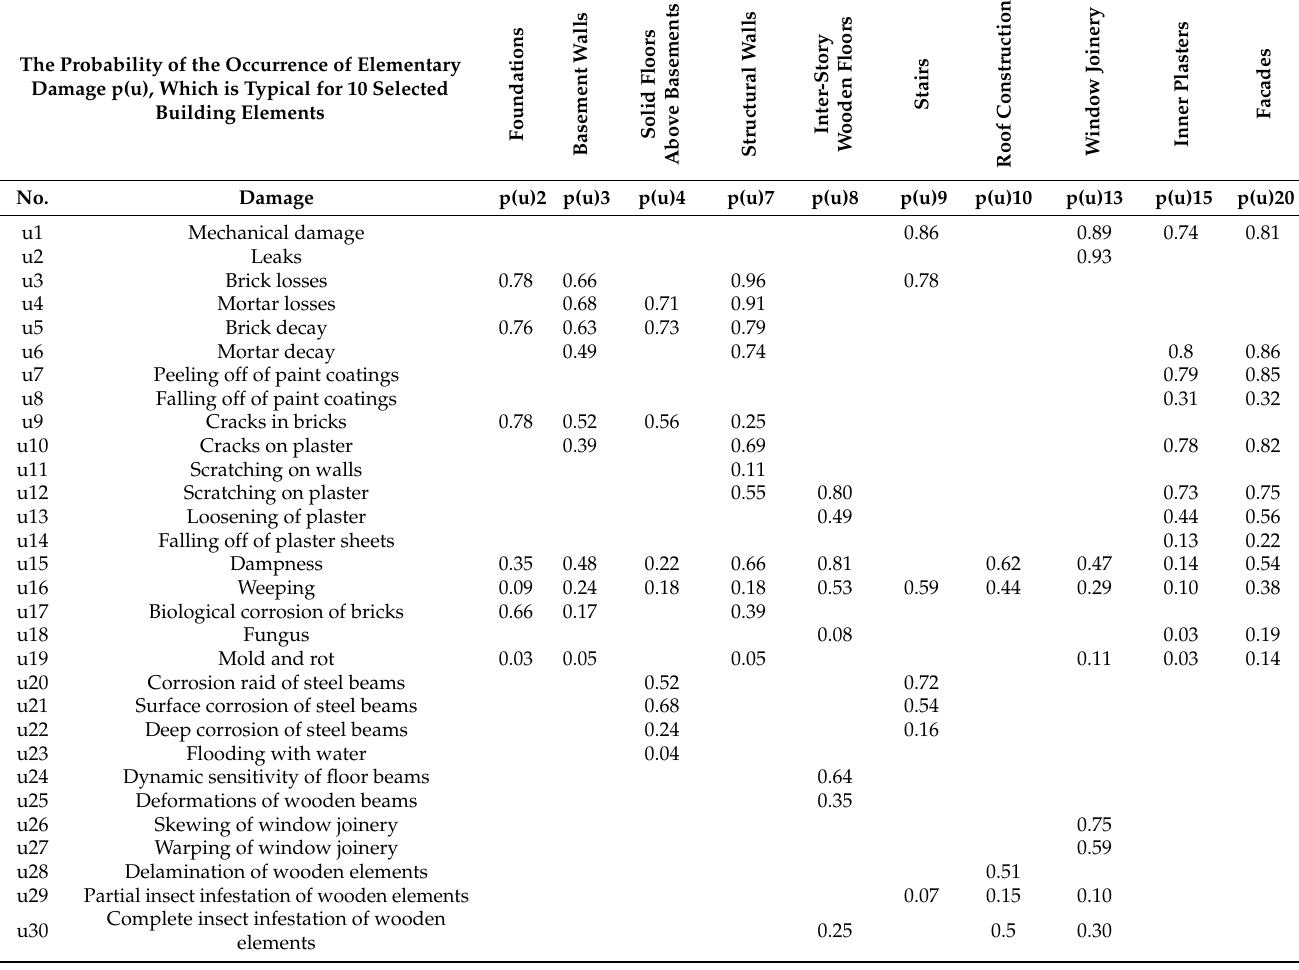
Table 2. Damage and the probability of its occurrence in 10 elements of the examined